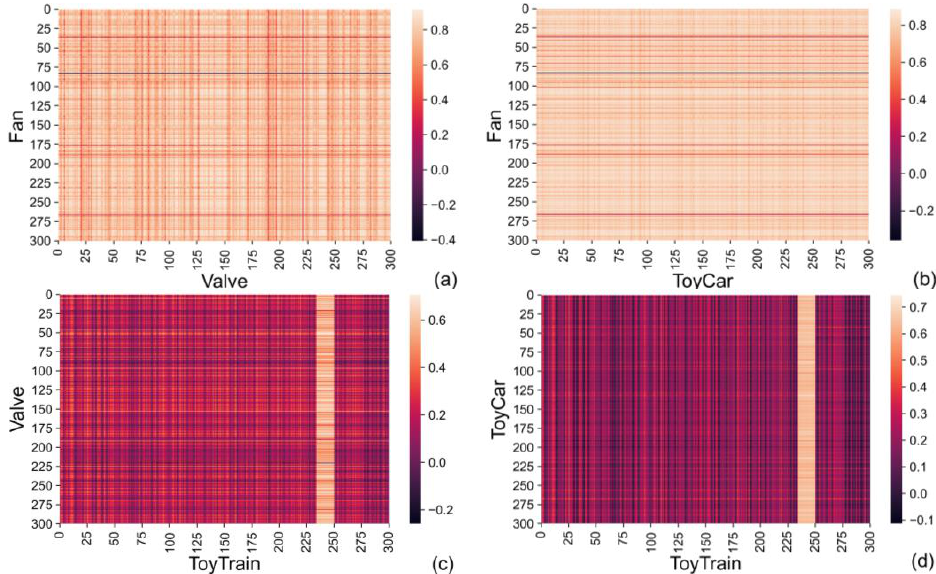
Figure 8. Interclass PCC similarity values in the form of heat map for the extracted dataset: ( a ) be- tween fan and valve, ( b ) between fan and toy-car, ( c ) between valve and toy-train, and ( d ) between toy-car and toy-train (ranges of values are given in the provided color bars, and they are not the same for presented heat maps).